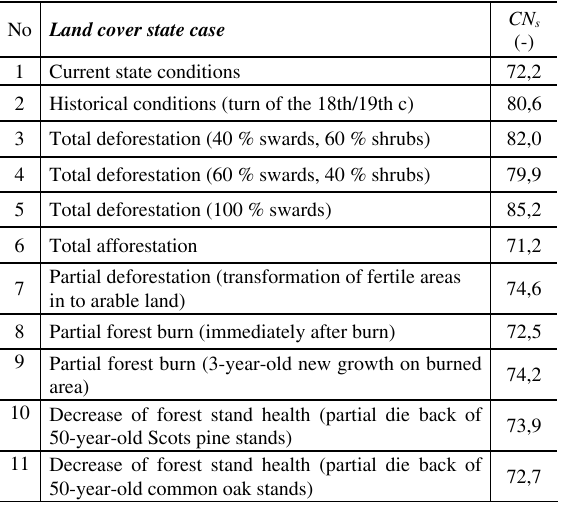
Table 4 . Values of CN parameters for specified land cover state cases of Trojanka catchment